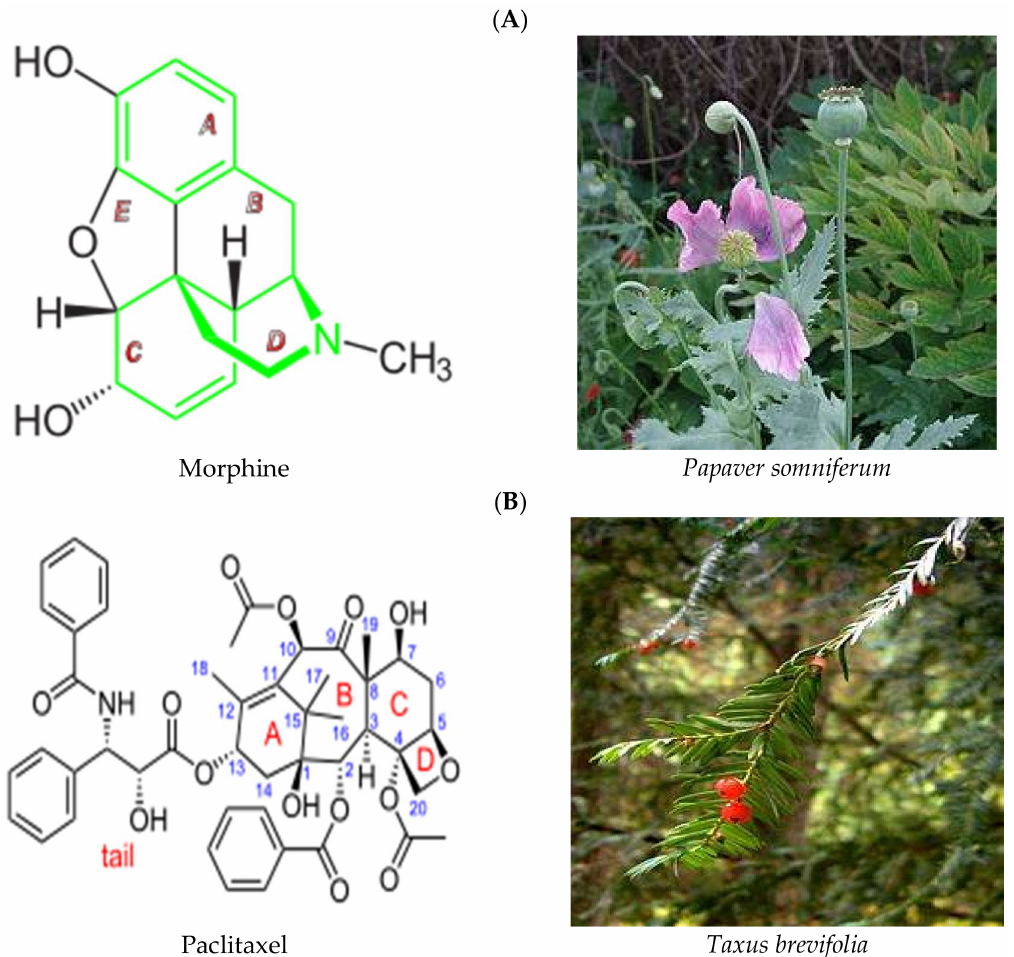
Figure 1. Two examples of successful stories of plant natural products that are being used in hospitals and clinics for disease treatment. ( A ) Morphine is isolated from Papaver somniferum also called opium poppy ( B ) Paclitaxel is isolated from Taxus brevifolia also called pacific yew. (Images credit: